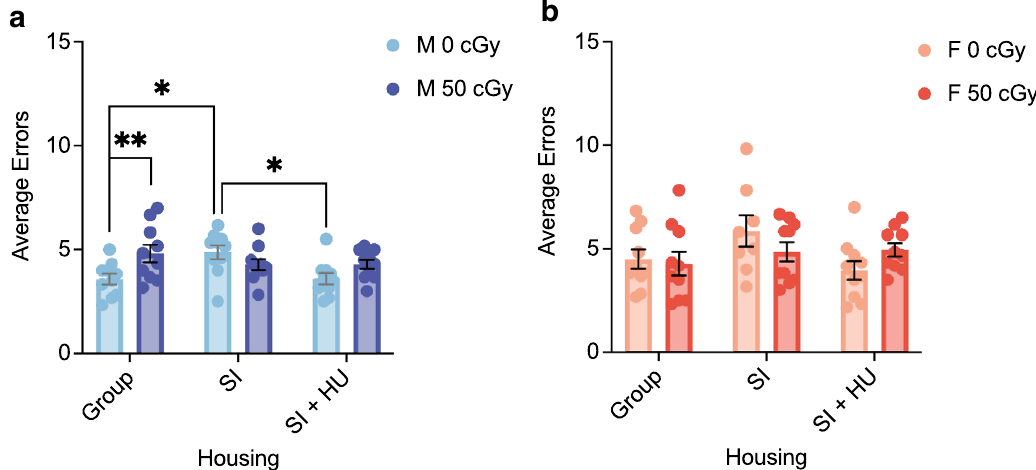
Figure 2. Combined stressors and biological sex differences in spatial learning. Radial Arm Water Maze (RAWM) was used to measure spatial learning under different housing and treatment conditions. Total Average Errors over 6 trials for Males ( a ) and Females ( b ). A two-way ANOVA showed a significant interaction between GCR and Housing for Total Average Errors (F(2,54) = 4.838, p = 0.012, η 2 = 0.152). The simple main effect of GCR (F(1,54) = 8.340, p = 0.006, η 2 = 0.134) showed a significant increase in average errors in 50 cGy compared to 0 cGy group housed males (mean diff 1.233, 95%CI(.377 to 2.090), p = 0.006), and the simple main effect of housing (F(2,54) = 6.036, p = 0.004, η 2 = 0.183) showed a significant increase in average errors in 0 cGy SI males compared to 0 cGy group housed (mean diff 1.293, 95%CI(.238 to 2.349), p = 0.011) and SI + HU housed males (mean diff 1.277, 95%CI (.221 to 2.332), p = 0.013). Males: n = 10 per group for 60 total mice. Females: n = 10 for all groups except Group 50 cGy (n = 9), SI 0 cGy (n = 8) for 57 total mice. * p < 0.05, ** p < 0.01.